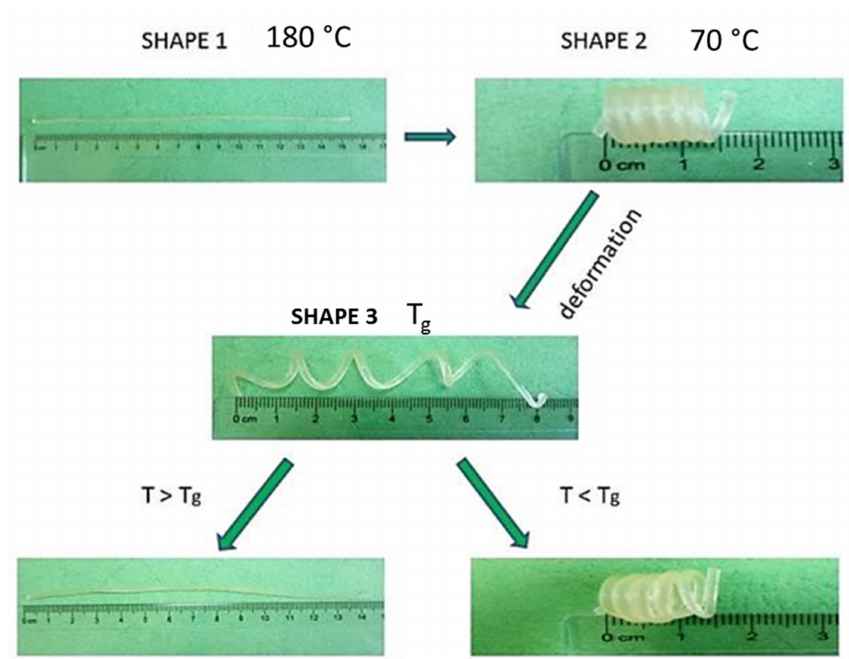
Figure 5. The course of the experiment showing the triple-shape memory e ff ect; Shape 1—wire fixed by extrusion at 180 ◦ C, Shape 2—spring shape fixed by mechanical deformation conducted at 70 ◦ C, Shape 3—the shape of a stretched spring fixed by the mechanical deformation of Shape 2 conducted at the glass transition temperature. The return from Shape 3 to a permanent Shape 1 or Shape 2 is controlled by the selection of the temperature t value. Sequential photographs taken of the recovery of the blend PLLAGL / BSCA 80 /